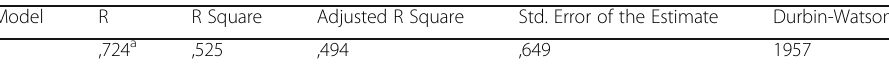
Table 19 Model Summary R3 b Model